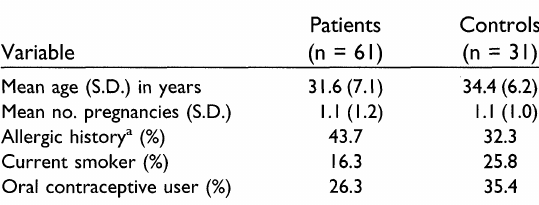
TABLE I. Demographic and historical variables in patients and controls